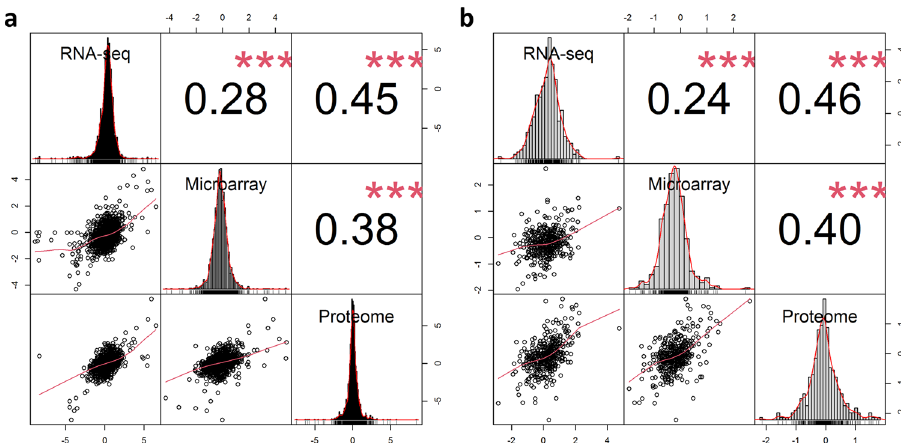
Fig. 1 Correlation of the log-fold differences in D492 and D492M of common gene identi fi ers between RNA sequencing, microarray and proteomic data. a Correlation of log-fold differences of all common gene identi fi ers ( n = 2271). b Correlation of log-fold differences of common metabolic gene identi fi ers ( n = 395). Spearman ’ s rank correlation coef fi cient was used. The asterisks represent a signi fi cant correlation ( p <